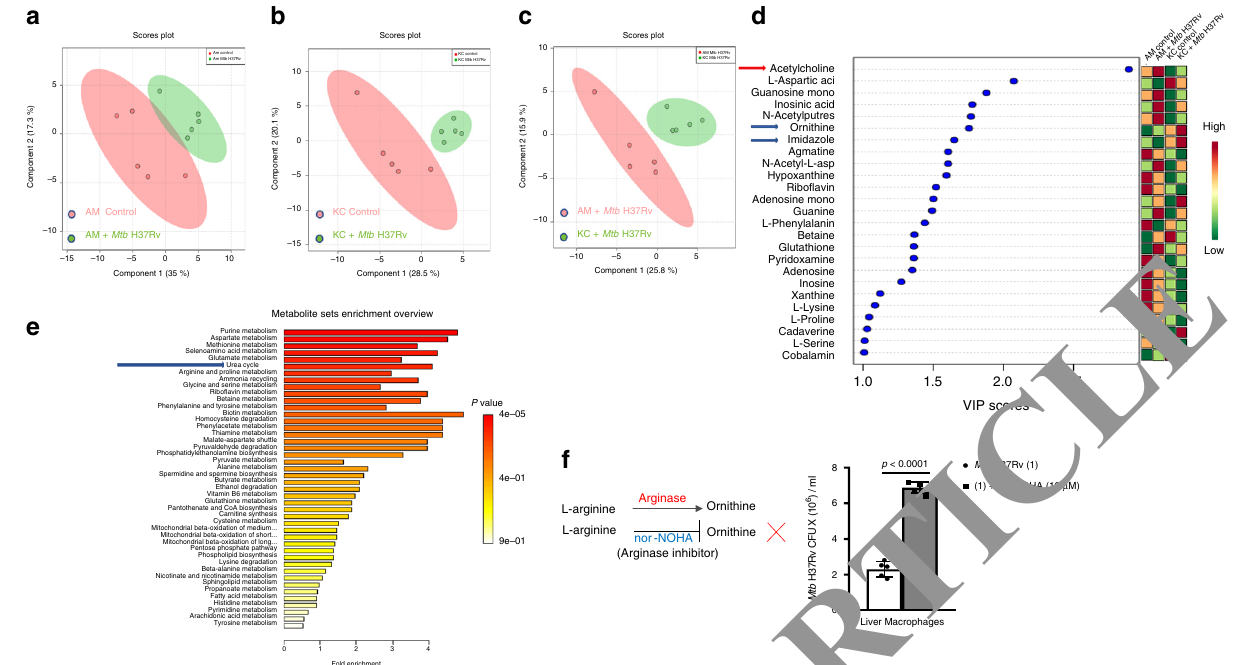
Fig. 4 Metabolic pro fi les of Mtb -infected AMs and KCs. AMs and KCs from C57BL/6 mice were isolated and infected with Mtb H37Rv. After 72 h, cell lysates were analyzed using LC-MS. A representative score plot of the partial least squares discriminant analysis (PLS-DA) was generated using MetaboAnalyst. PLS-DA models were validated using R 2 and Q 2 based on LOOCV (leave one out cross-validation); the four-component model was selected as the optimized model with R 2 = 0.95 and Q 2 = 0.58. The signi fi cance of the model was demonstrated by a permutation test with 100 testing iterations using a separation distance of p < 0.01. a AMs control (red); AMs Mtb H37Rv (green). b KCs control (red); KCs Mtb H37Rv (green). c AMs Mtb H37Rv (red); KCs Mtb H37Rv (green). d Representation of 25 metabolites with VIP (variable importance of projection) scores greater than 1.0 based on PLS-DA considered signi fi cant. On the extreme right, red and green indicates high and low levels of metabolites, respectively. e Quantitative metabolite sets enrichment overview using metabolite set enrichment analysis (MSEA) with the fold change showing the metabolic pathways of 25 metabolites selected based on their VIP scores greater than 1. The arrow indicates upregulated metabolites and pathways in Mtb H37Rv-infected KCs. f KCs from C57BL/6 mice were isolated and infected with Mtb H37Rv at an MOI of 1:2.5 (1 AM and 2.5 Mtb ). At 2 h post-infection, nor-NOHA were added at indicated concentrations. Intracellular CFUs were demonstrated 5 days post-infection. Statistical analysis was performed with paired two-tailed t test and presented as mean ± SD. Data shown are representative of fi ve independent